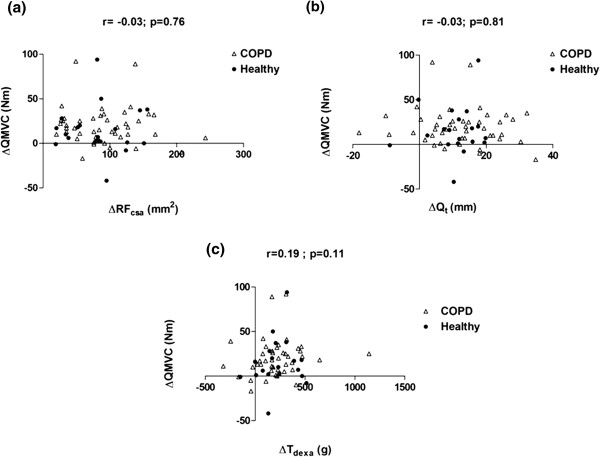
Relationships between training induced changes in quadriceps strength (ΔQMVC) and (a) ΔRFcsa, (b) ΔQt, and (c) ΔTdexa.